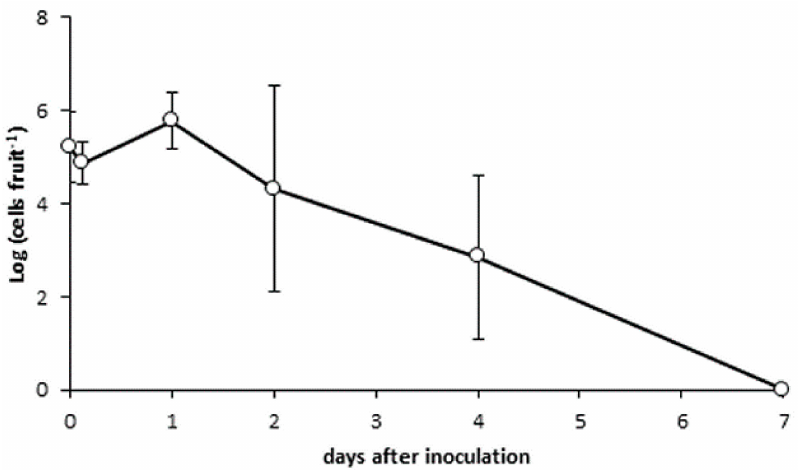
Figure 3. Survival of Photorhabdus luminescens on cherry fruit over 7 days after